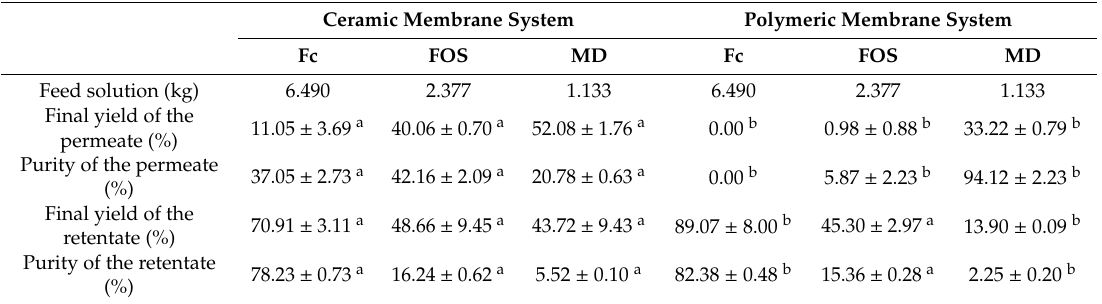
Table 4. Global yield of tight ultrafiltration (UF) process with ceramic and polymeric membrane